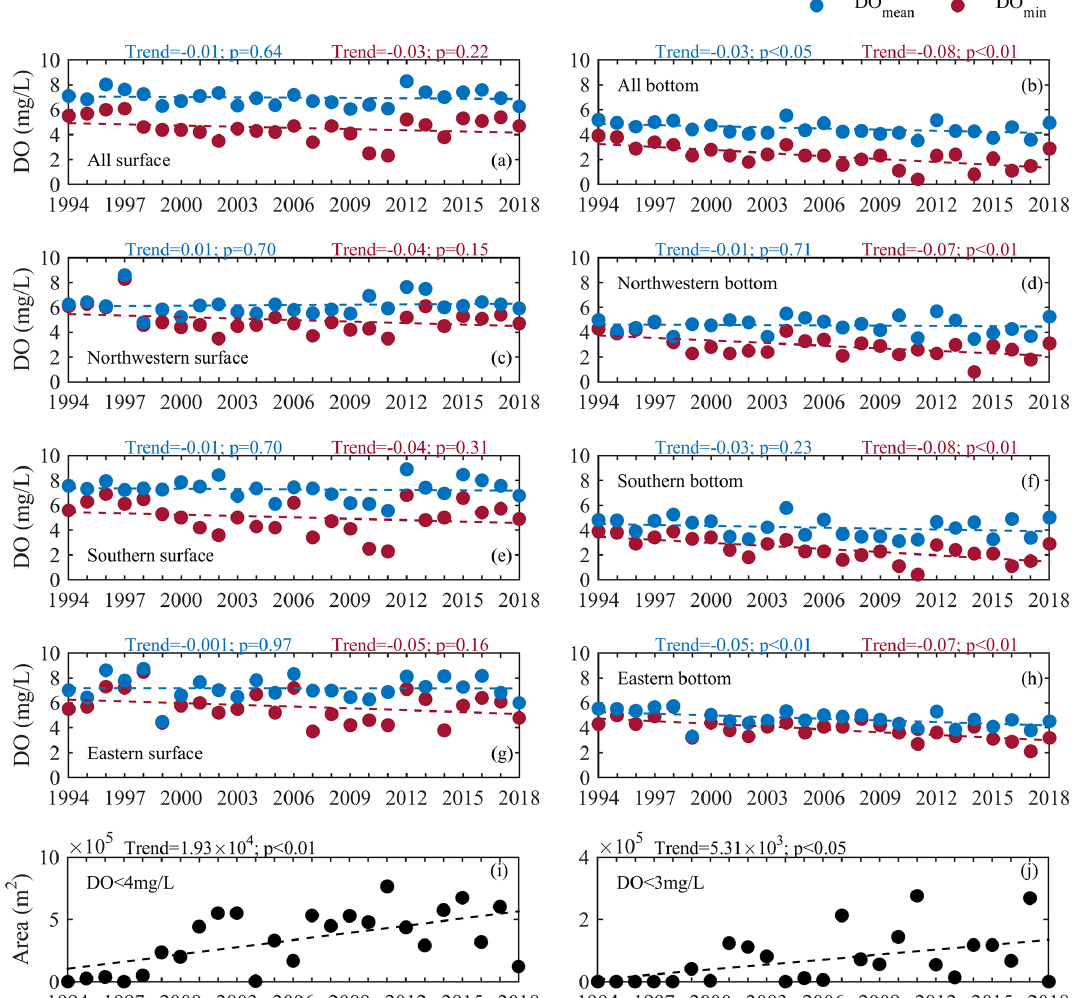
Figure 5. Long-term trends of the mean and minimum values of observed dissolved oxygen (DO) on the surface and in bottom waters in 3 summer months for all the stations (a, b) and for the northwestern (c, d) , southern (e, f) , and eastern (g, h) subregions, and long-term trends of the cross-sectional areas of low oxygen (i) and oxygen deficiency (j)